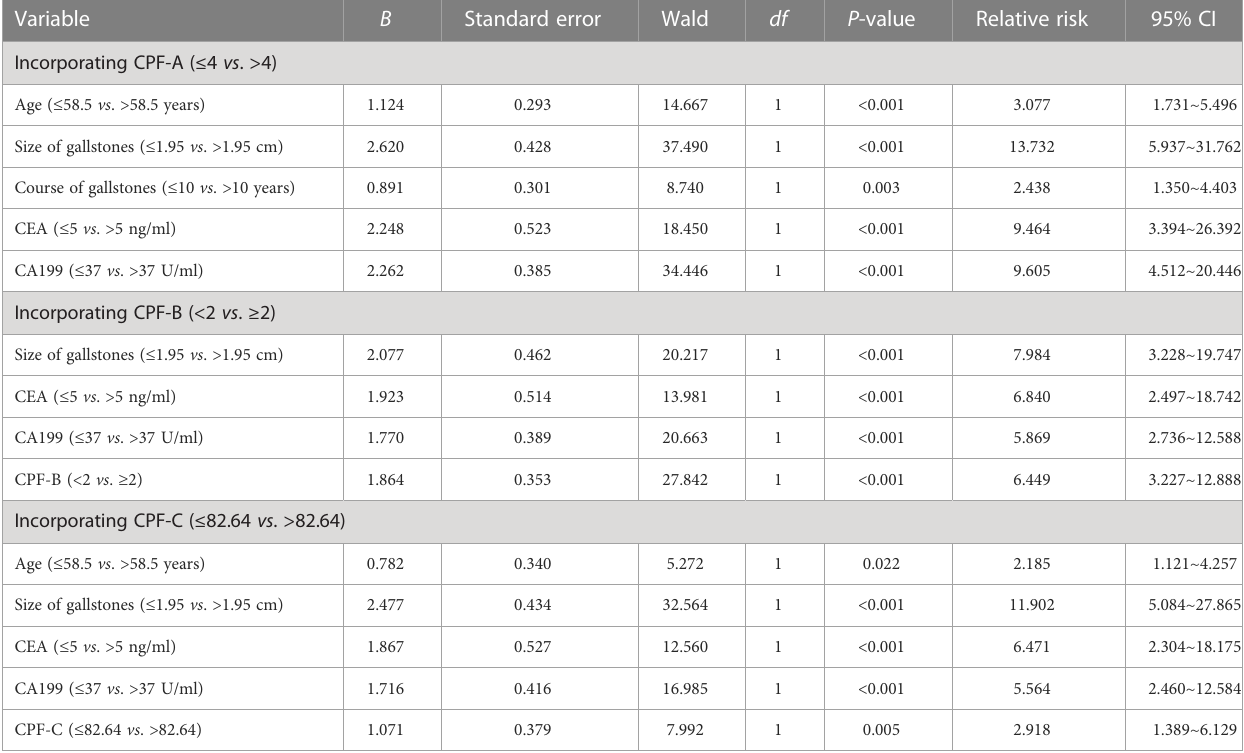
TABLE 4 Multivariate analysis after incorporating CPF-A, CPF-B, and CPF-C in the internal test samples. Variable B Standard error Wald df P -value Relative risk 95%